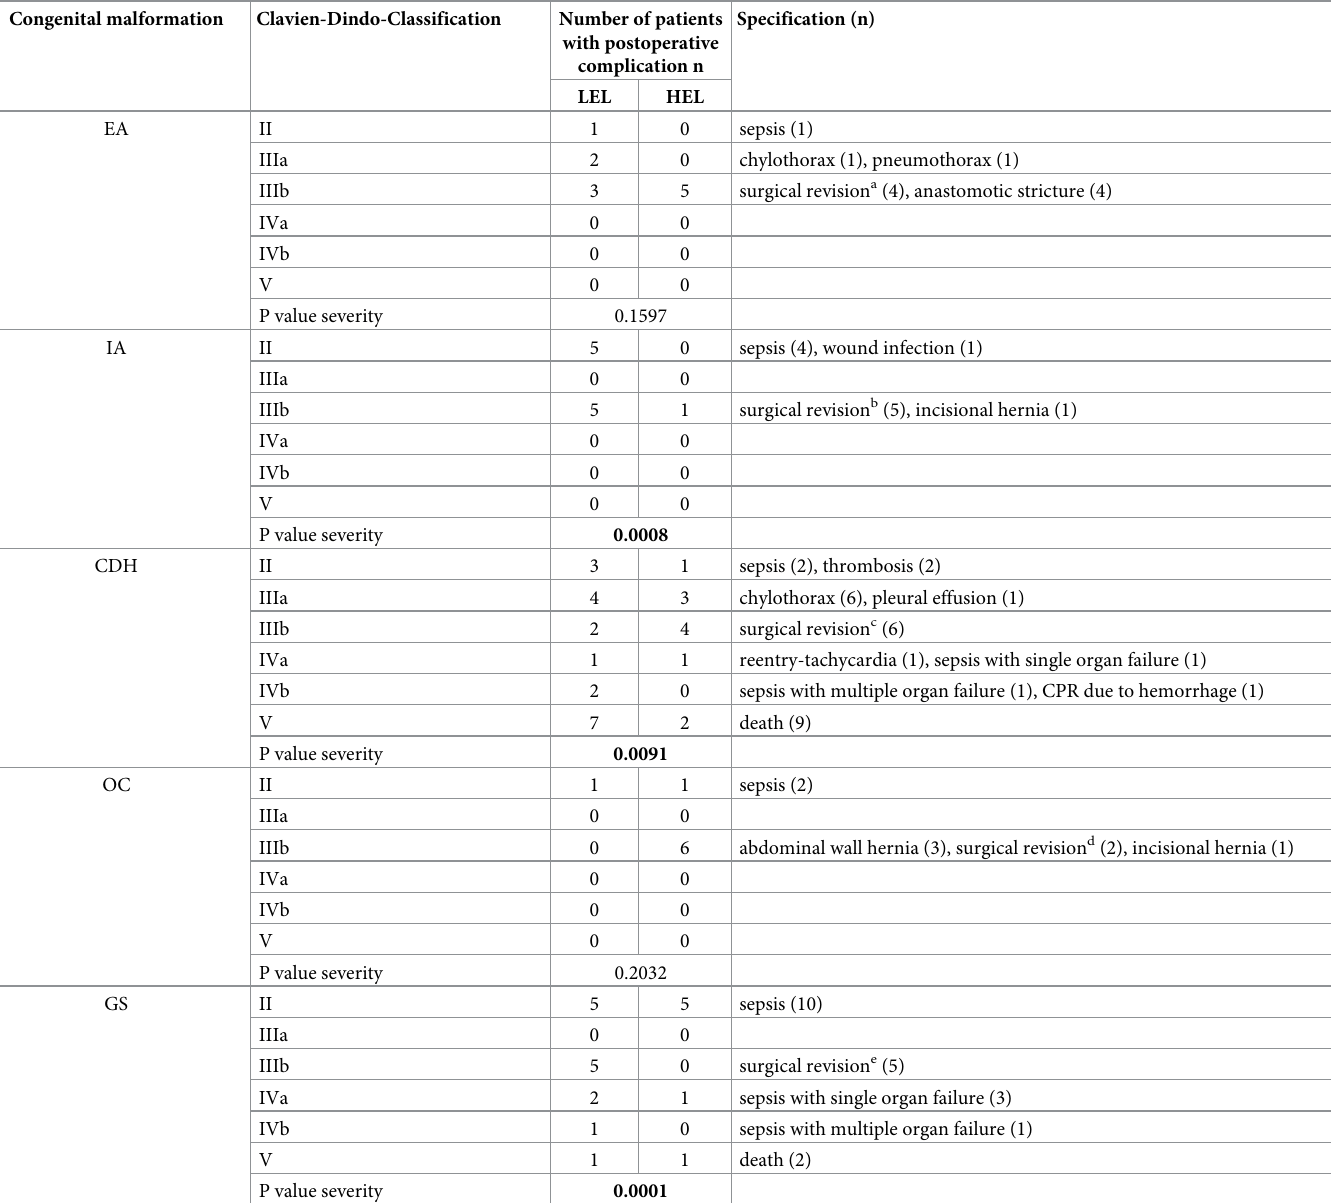
Table 4. Definition of postoperative complications and categorization according to the Clavien-Dindo Classification. Congenital